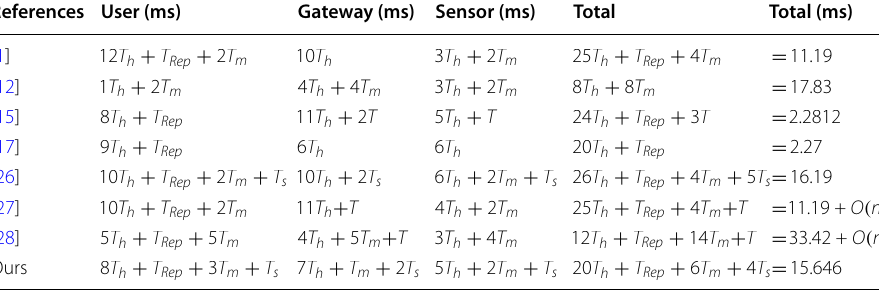
Table 7 Computation cost comparison